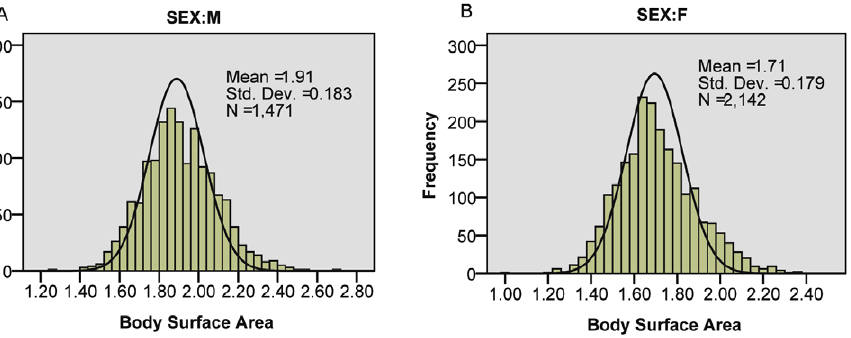
Figure 2. Histograms depicting the distribution of body surface area in men and women undergoing chemotherapy. As illustrated, the distribution approximates normal in both sexes.